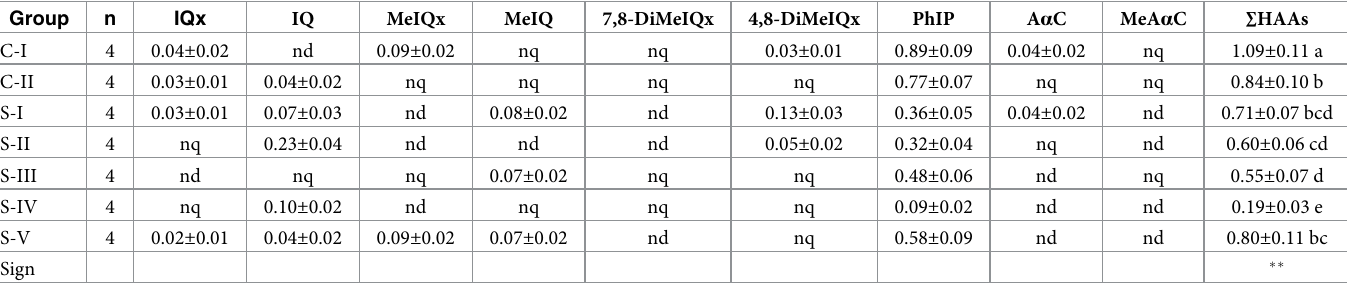
Table 2. Heterocyclic aromatic amine (HAA) contents of the barbecued salmon fillets non-smoke flavored and smoke flavored with different smoking wood chips